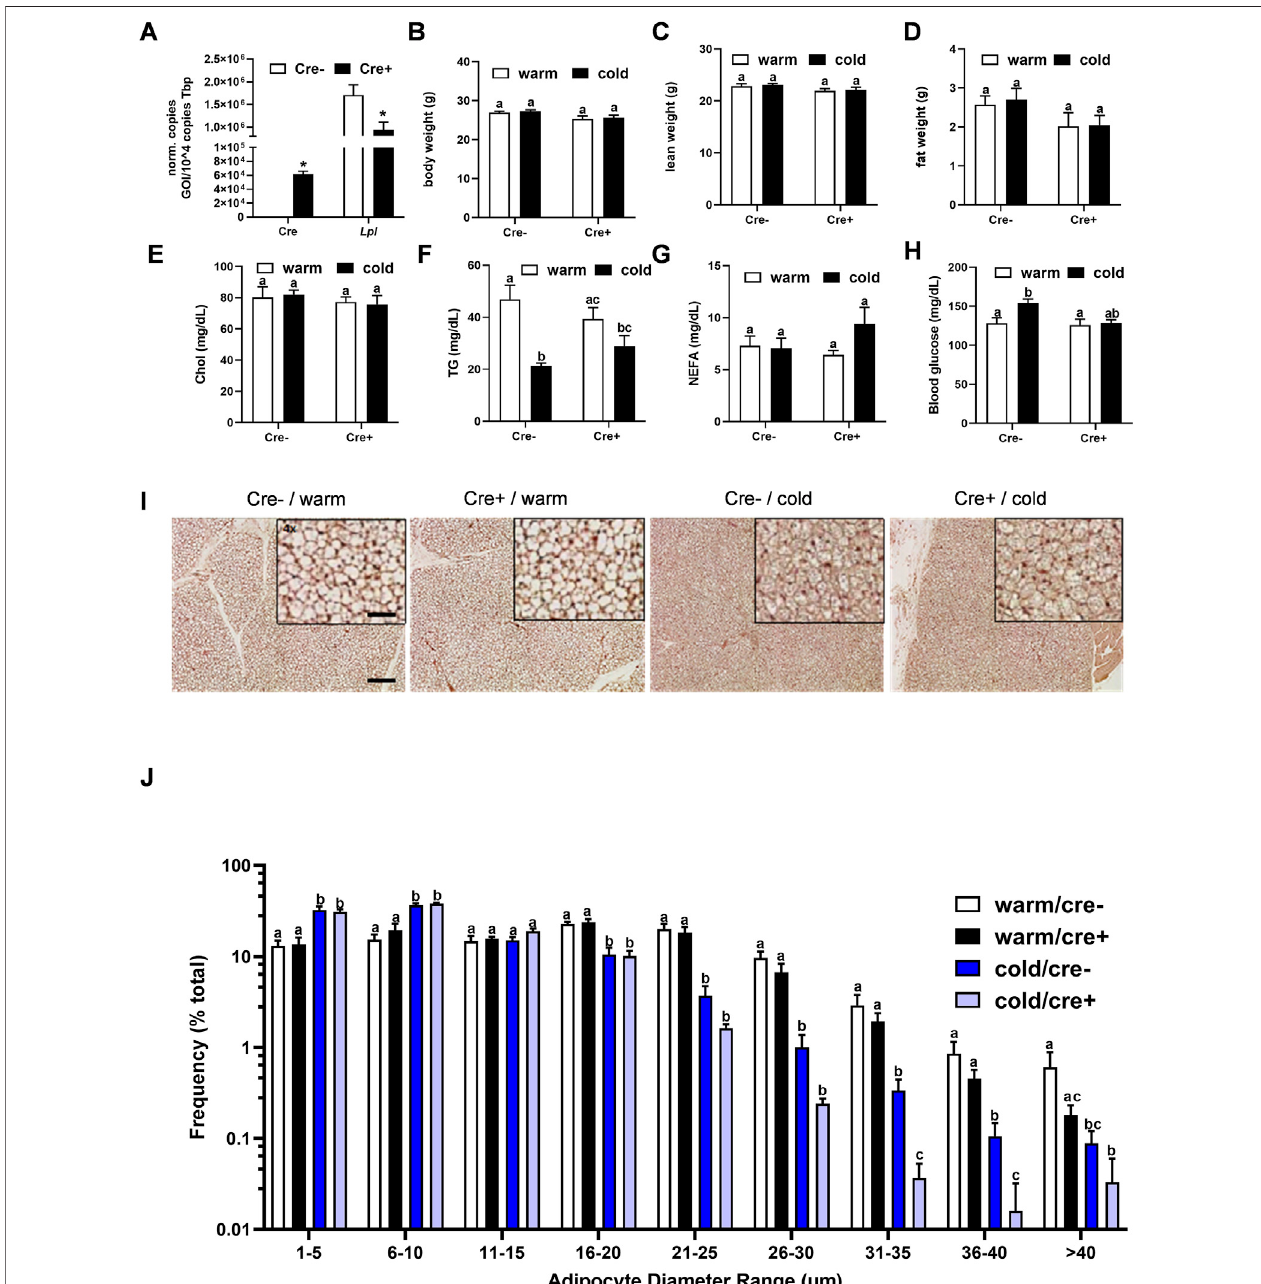
FIGURE2| BodycompositionandBATlipidcontentinendothelial cellspeci fi cLPLknockoutmice. (A) Controland EndoLPLkomice receivedatamoxifen dosage to generate mice lacking LPL in endothelial cells (Cre+) and controls (Cre-). Mice were exposed to 6 ° C for 1 day before SVF was isolated from BAT and analyzed for Cre and Lpl expression byqPCR(n=4). (B – E) EndoLPLkomiceand litter mates (n=6)werefedawestern-typedietfor2weeks,and housedat6 ° C(cold)or30 ° C(warm)in the second week. (B) Body weight, (C) lean weight and (D) fat weight determined by EchoMRI, (E) plasma cholesterol (chol), (F) triglycerides (TG), (G) non- esteri fi ed fatty acids (NEFA) and (H) blood glucose. (I) Hematoxylin eosin staining of BAT. Bars indicate 200 and 50 µm for lower and higher magni fi cation, respectively. (J) Rangesofadipocytediameterscalculatedfrom (I) usingNIS-Elements(Nikon ® ).Resultsarepresentedasmeanvalues±SEM.Statisticalsigni fi cancewasdetermined by Student ’ s t test (A) or by two-way ANOVA (B – D) . Same letter denotes groups that are not signi fi cantly different from each other ( p ≥ 0.05).